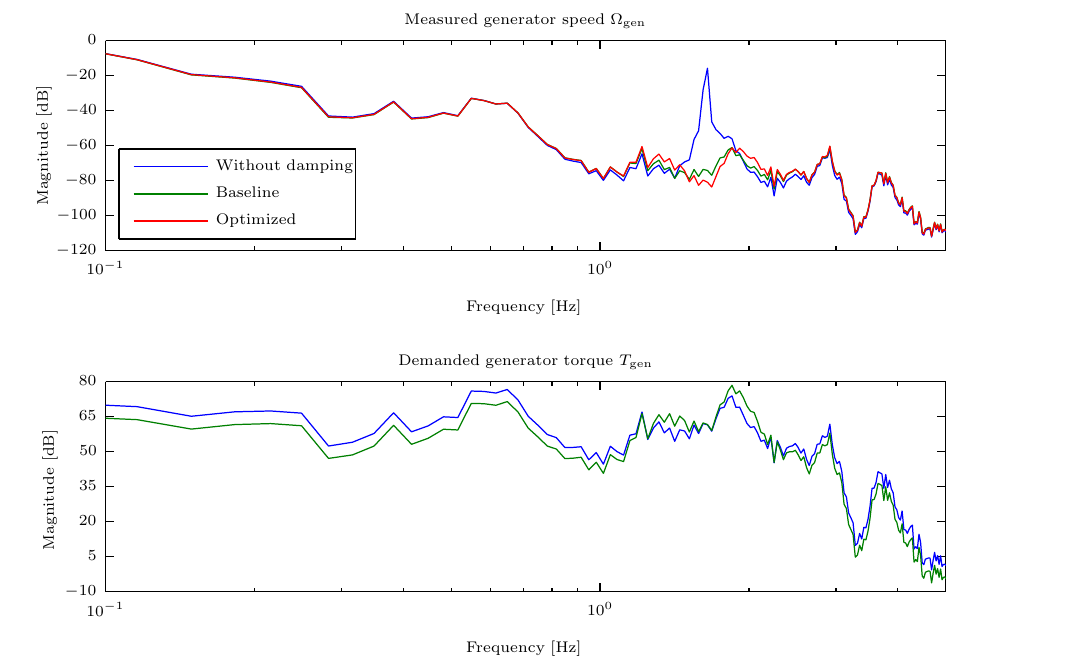
Figure 10. Comparison of the baseline and IFT-optimized drivetrain controller